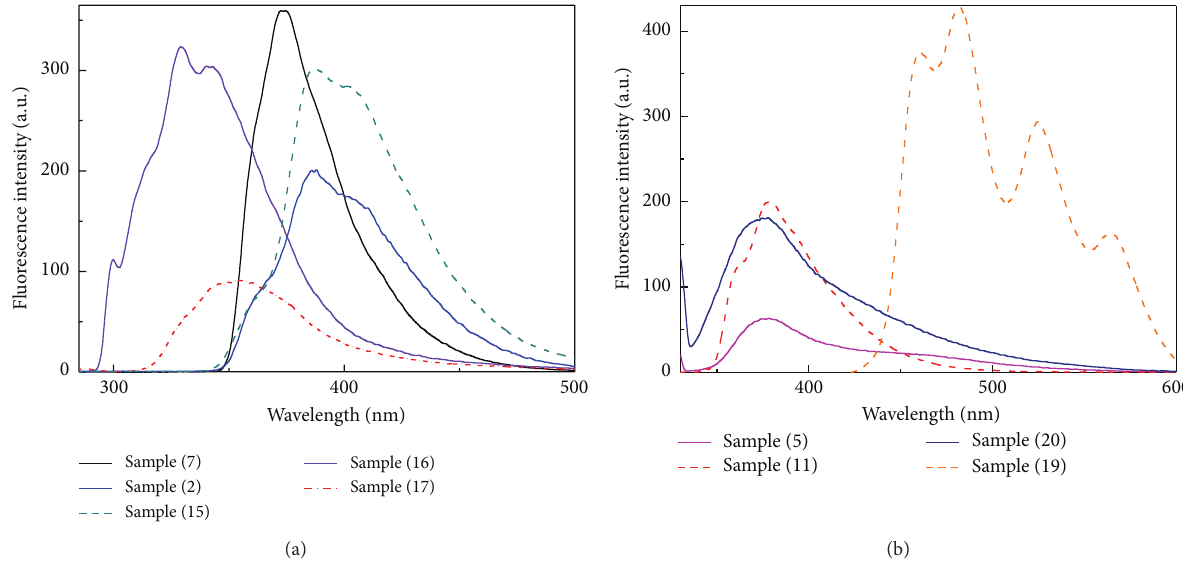
Figure 2: The fluorescence emission spectra of (a) samples: 2 , 7 , 15 , 16 , and 17 , (b) samples: 5 , 11 , 19 and 20 (all samples are kept at 0.02M).